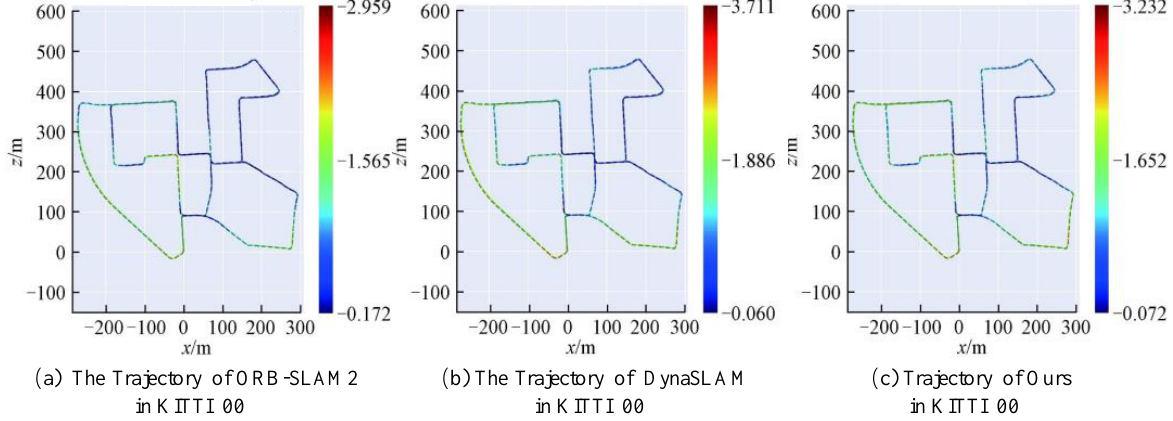
Figure 7. Comparison of camera translation trajectory errors in static sequence. ( a – c ) are the perfor- mance of ORB-SLAM2, DynaSLAM and our method on KITTI 00, respectively. Blue indicates the smallest trajectory error, followed by green, and red indicates the largest trajectory error. The absolute trajectory error of the system under a low dynamic sequence is shown in Figure 8. This method can overcome the interference of dynamic objects and has the best performance in ground truth trajectory estimation. However, this advantage is not prominent in low dynamic scenarios. The reason may be due to the (RANSAC) outlier detection method used by ORB-SLAM2 and its resistance to a certain degree of active interference.